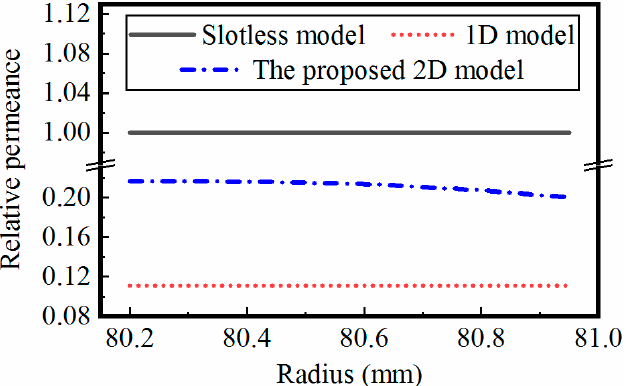
Figure 10. The minimum value of relative permeance and its dependence on the radius.